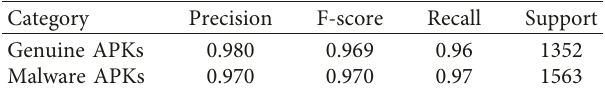
Table 4: Classification statistics using transfer learning (AAGM data